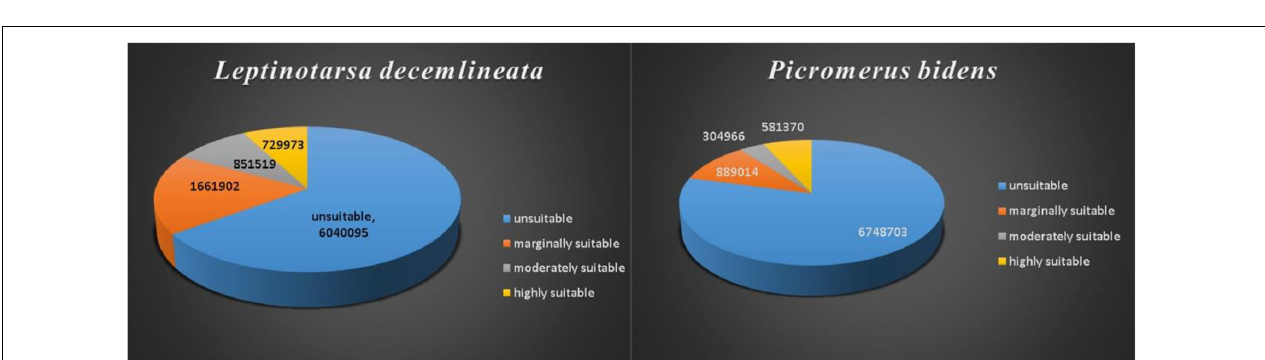
FIGURE 5 | Area of habitats with different suitability for CPB and P. bidens under current climate.